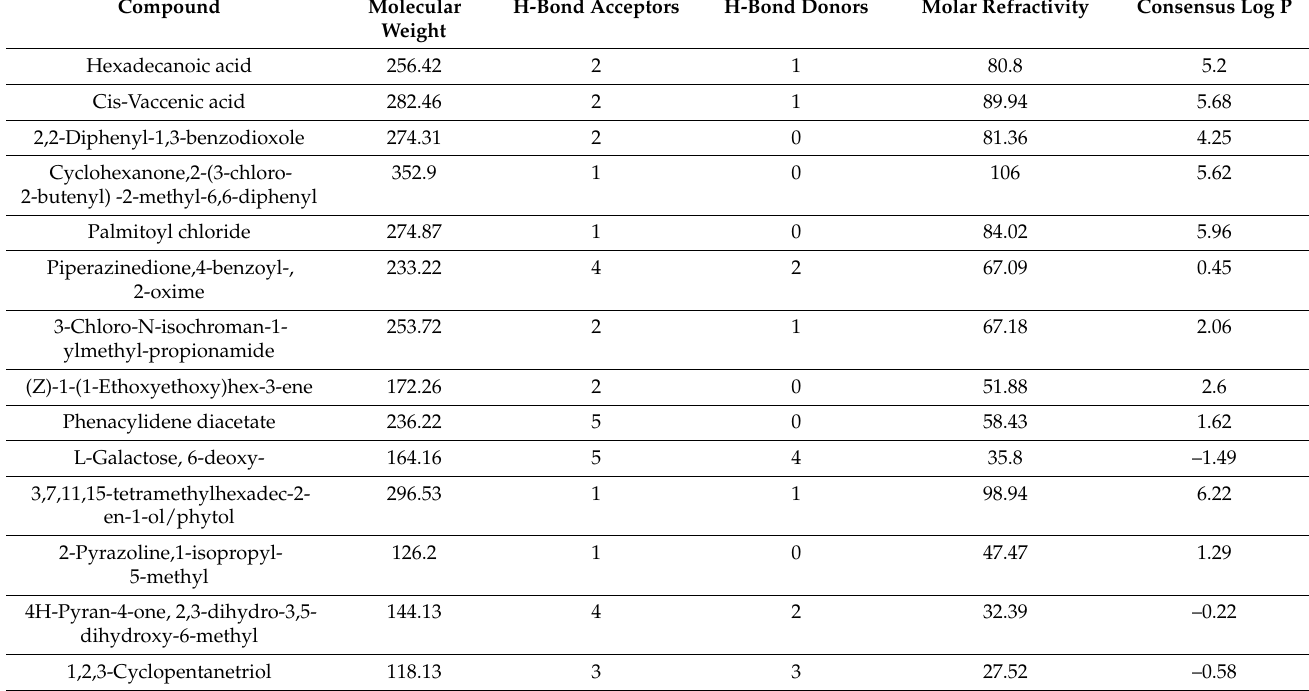
Table 4. Evaluation of Lipinski filter.